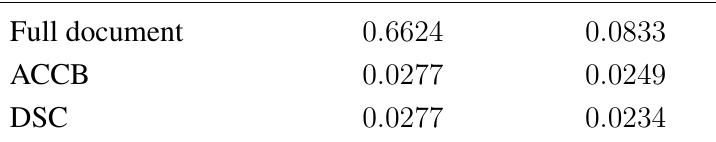
Table 4. MSE with and without bias